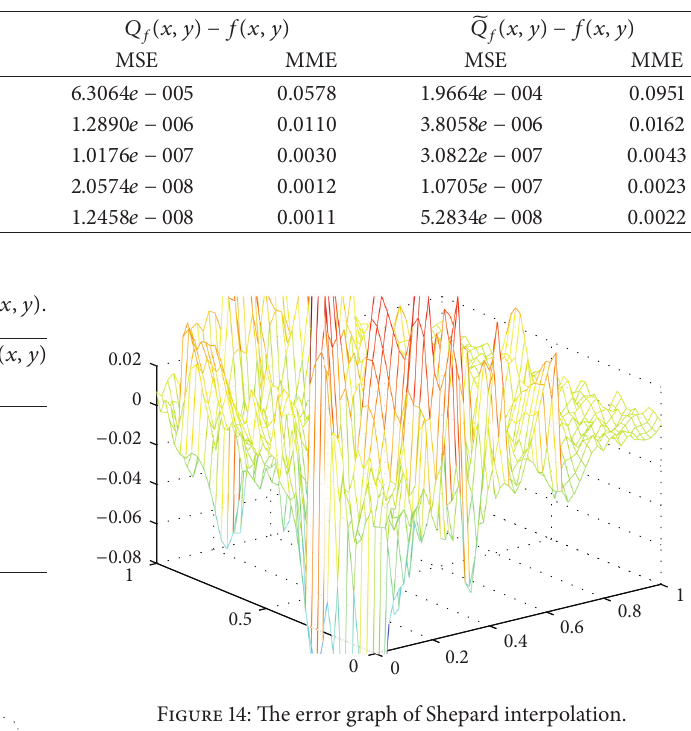
Table 1: The comparison of MSE and MME of 𝑄 𝑓 (𝑥 , 𝑦) and